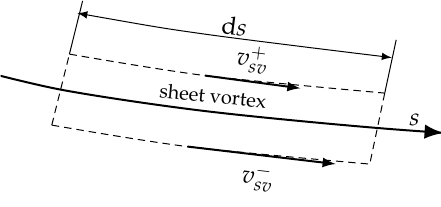
Figure 2. Infinitesimal sheet-vortex